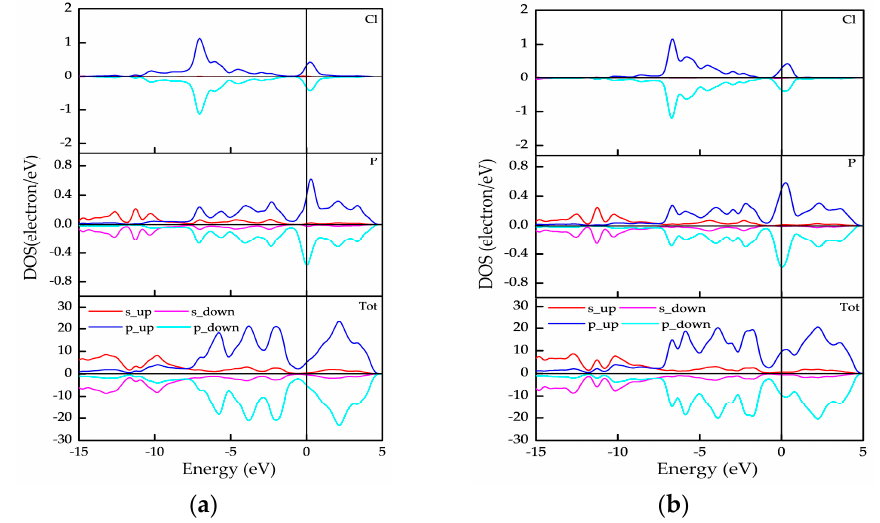
Figure 5. partial density of states (PDOSs) of doped phosphorenes with antiferromagnetic order: ( a ) P 62 Cl 2 and ( b ) P 60 Cl 4 .